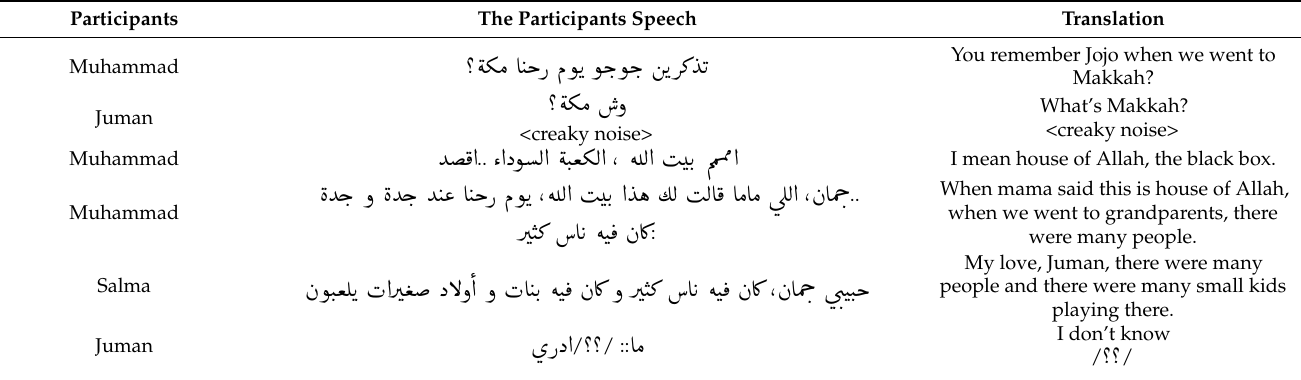
Table 2. Excerpt